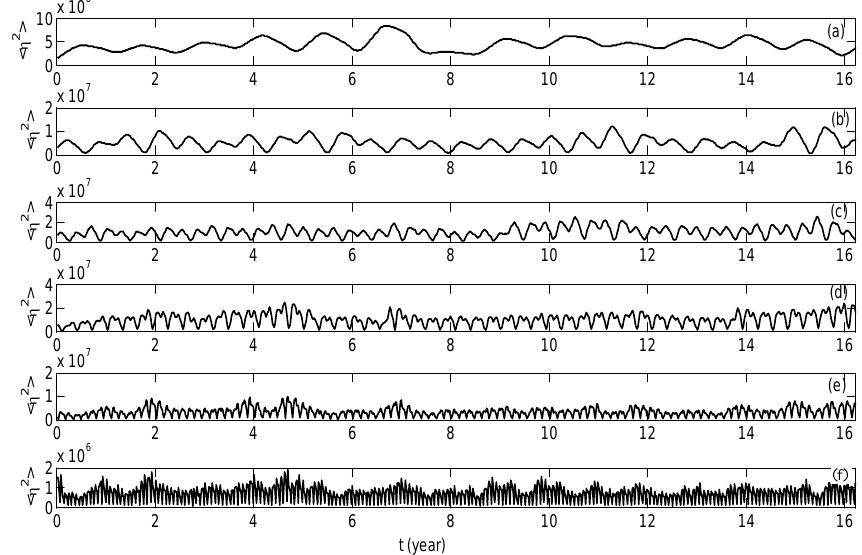
D E η 2 Figure 4. Temporal behavior of (cm 2 ) for six spectral bands: (a) longer than 36 months, quasi-zonal jets; (b) 18 to 36 months, biannual oscillations; (c) 8 to 18 months, annual Rossby waves; (d) 4 to 8 months, semiannual Rossby waves; (e) 2 to 4 months, mesoscale eddies; and (f) 1 to 2 months, mesoscale